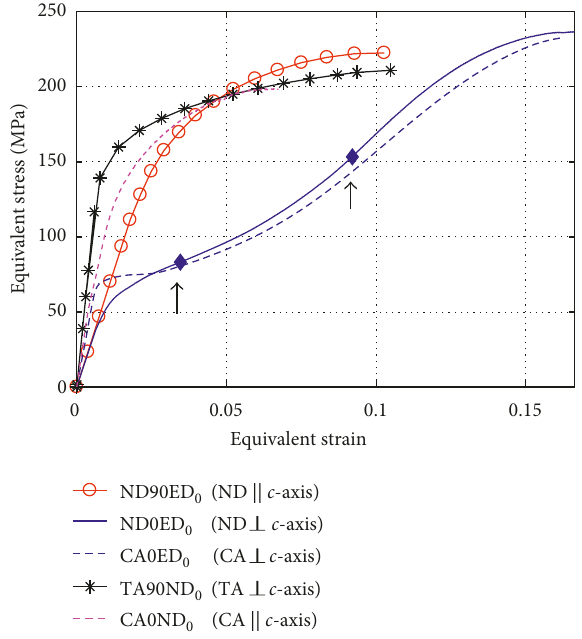
Figure 2: Flow curves of pure magnesium at room temperature under different mechanical tests including PSC (ND90ED 0 and ND0ED 0 ), simple compression (CA0ED 0 and CA0ND 0 ), and uniaxial tensile (TA90ND 0 ). The loading directions with respect to the typical crystallographic c -axis in most grains for each specimen are shown between